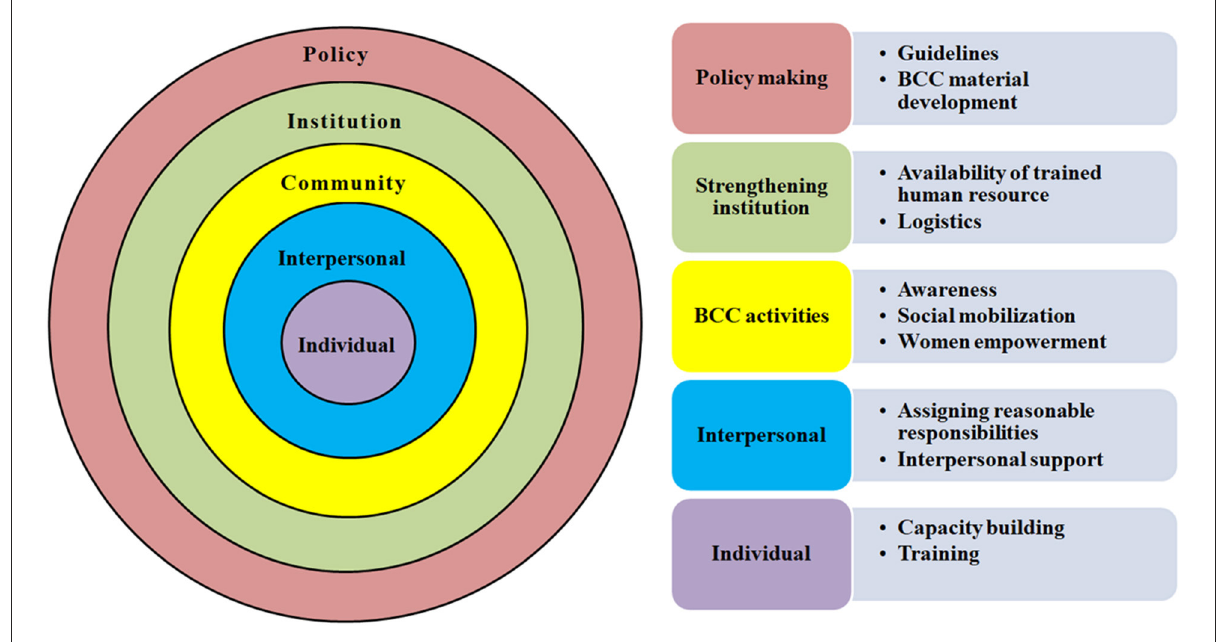
FIGURE2 Conceptual framework of a model for preconception care